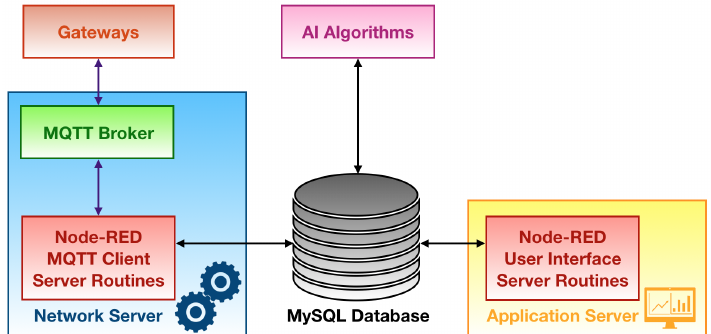
Figure 6. LoRaWAN server architecture block diagram. Violet arrows symbolize the MQTT connec- tions while the black ones represent the connections to the database. Gateways and AI algorithms have been included just for the sake of completeness even though they are not part of the server side of the network: the former ones are scattered on the environment while the latter ones reside in the cloud